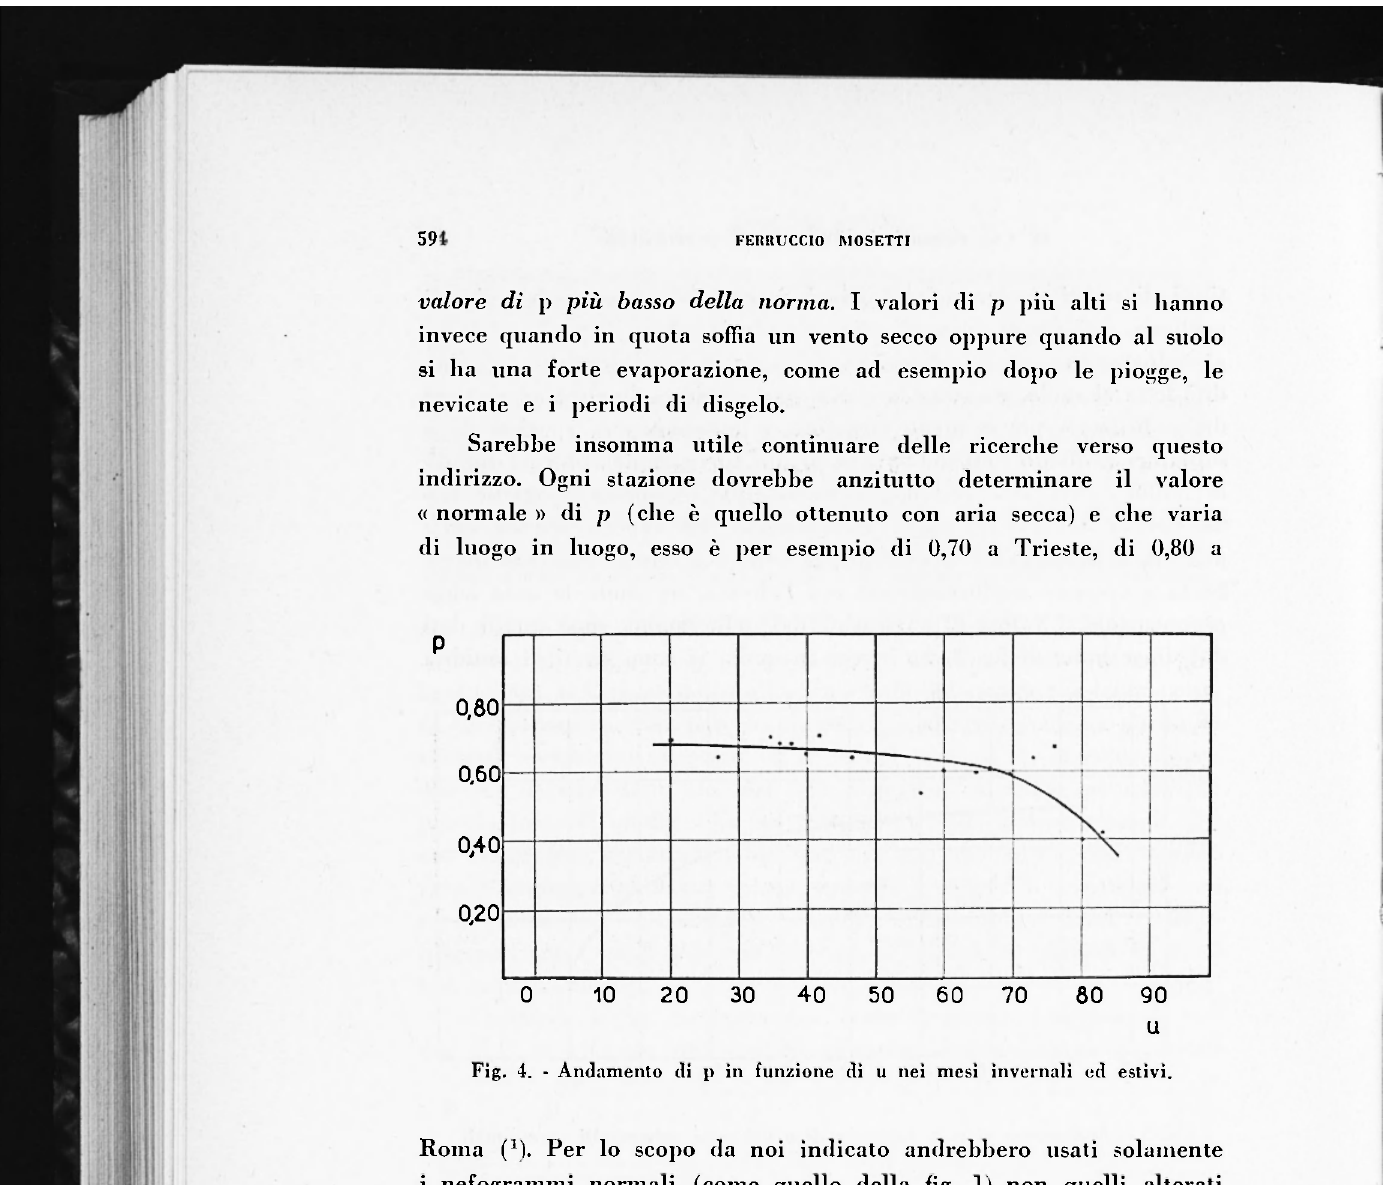
Roma ( x ). Per lo scopo da noi indicato andrebbero usati